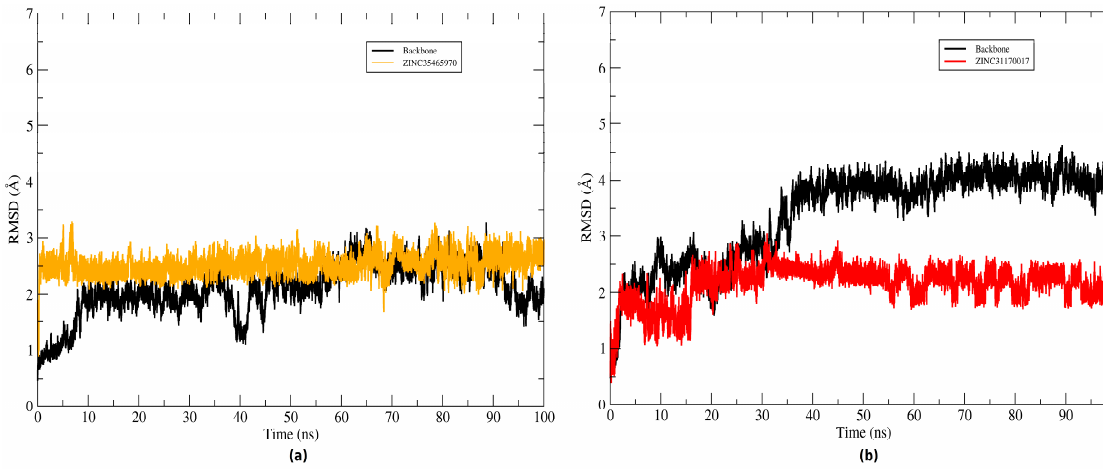
Figure 8. Evaluation of RMSD plots during MD simulations. The KasA protein backbone has been represented in black, while the ligands graphs have been represented in different colors. ( a ) RMSDs of the KasA- ZINC35465970 system and ( b ) RMSDs of the KasA-ZINC31170017 system.